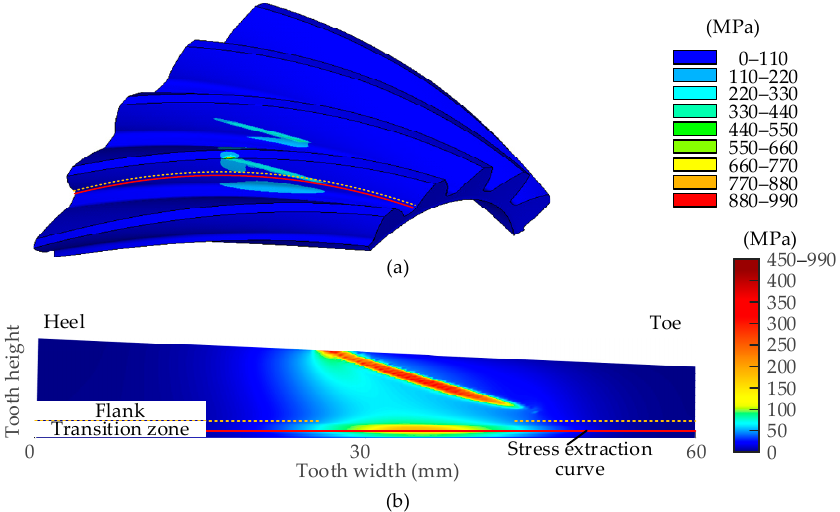
Figure 9. Contour plot of the von Mises stress distribution of the pinion: ( a ) 3D view; ( b ) Plane view.